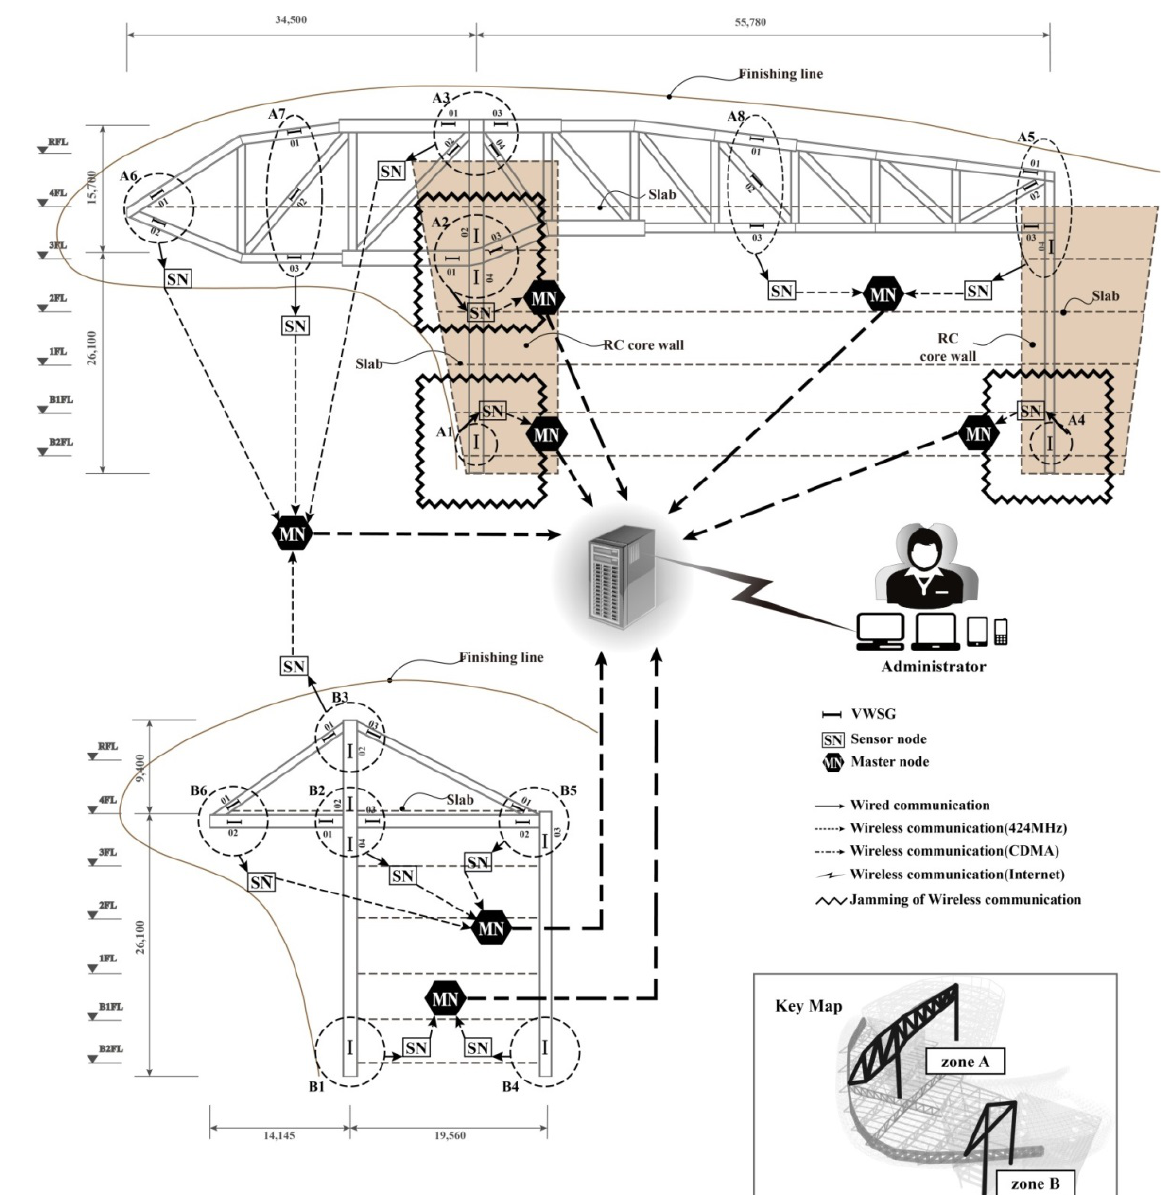
Figure 5. WSNS for the D-Building.